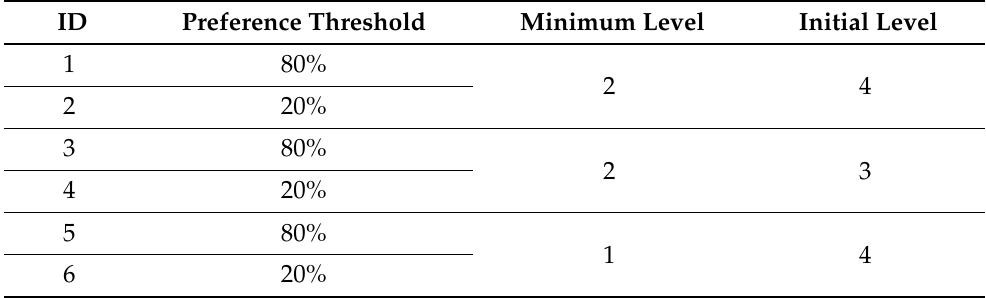
Table 4. Initial settings considered for